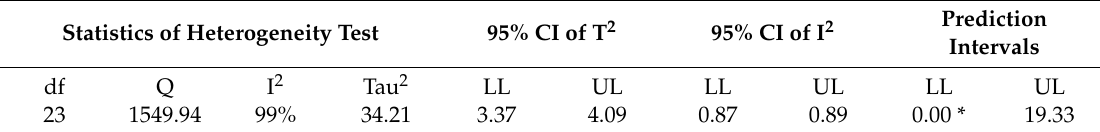
Figure 3. The forest plot of the comparison between the multi-modal therapies and uni-modal therapies. The Q statistic of the meta-analysis of all included studies (equal to Chi 2 ), T 2 , I 2 and their 95% confidence intervals and prediction intervals of the comparisons’ e ff ect could be seen in Table 4. Table 4. The result of heterogeneity test of all included